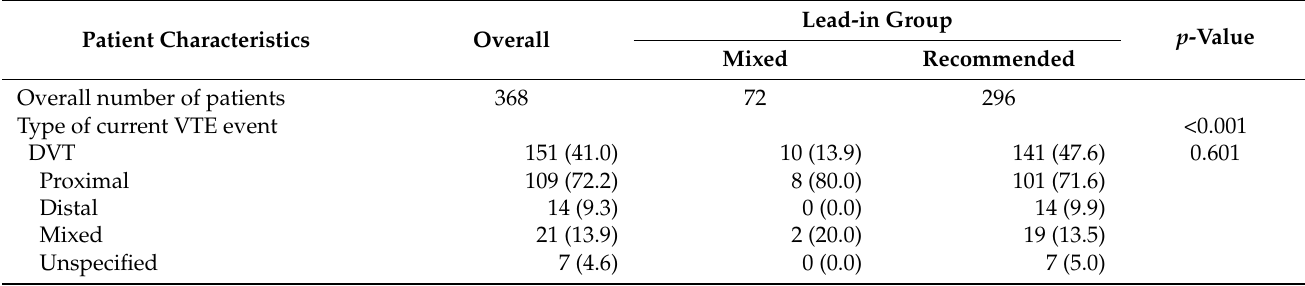
Table 3. Type and etiology of the new VTE event and the risk of